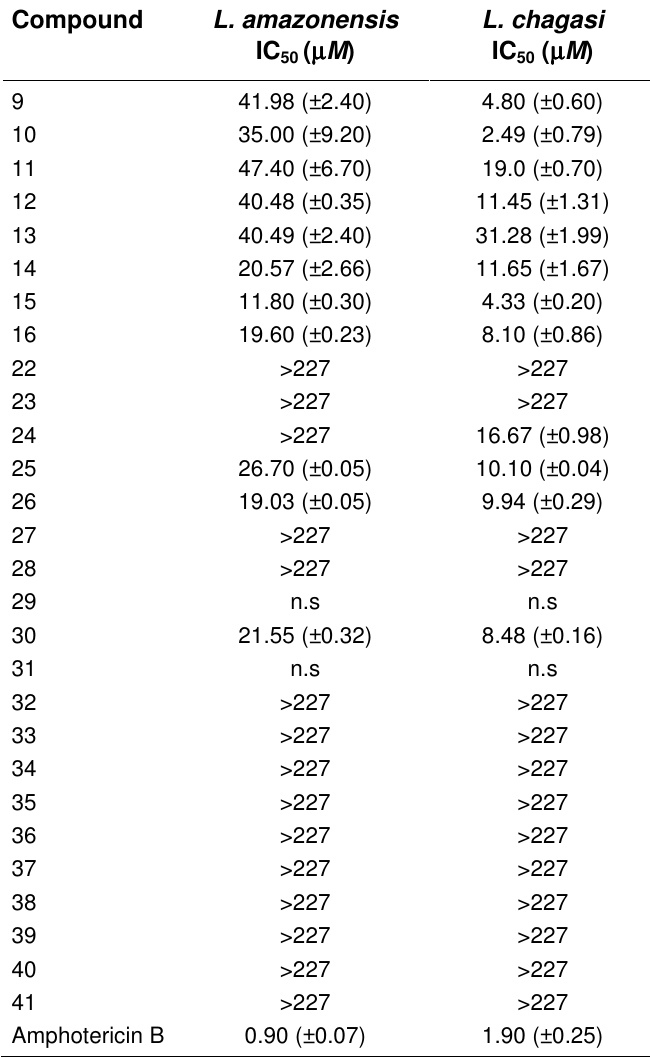
In vitro Antiproliferative Activity against L. amazonensis and L. chagasi Promastigote